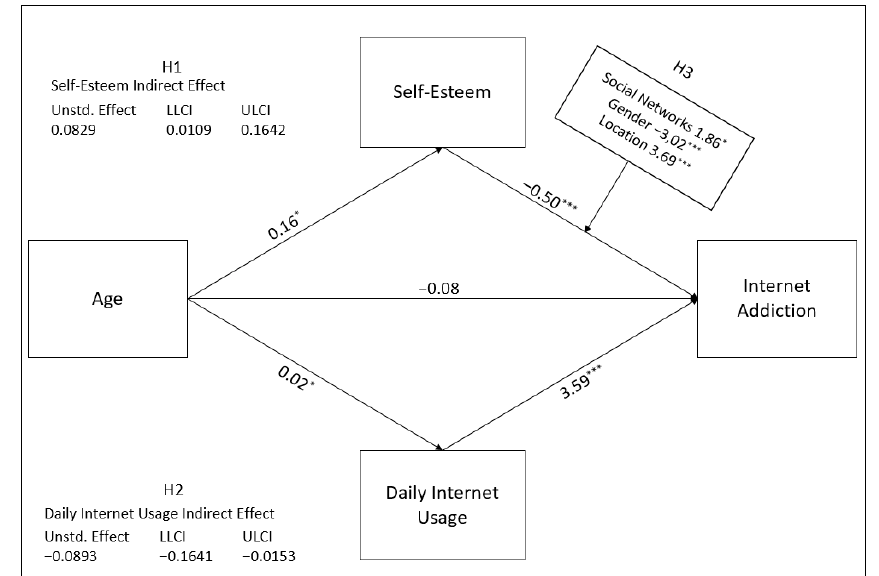
Figure 5. Results of the proposed research model, * p < 0.05, *** p < 0.001.